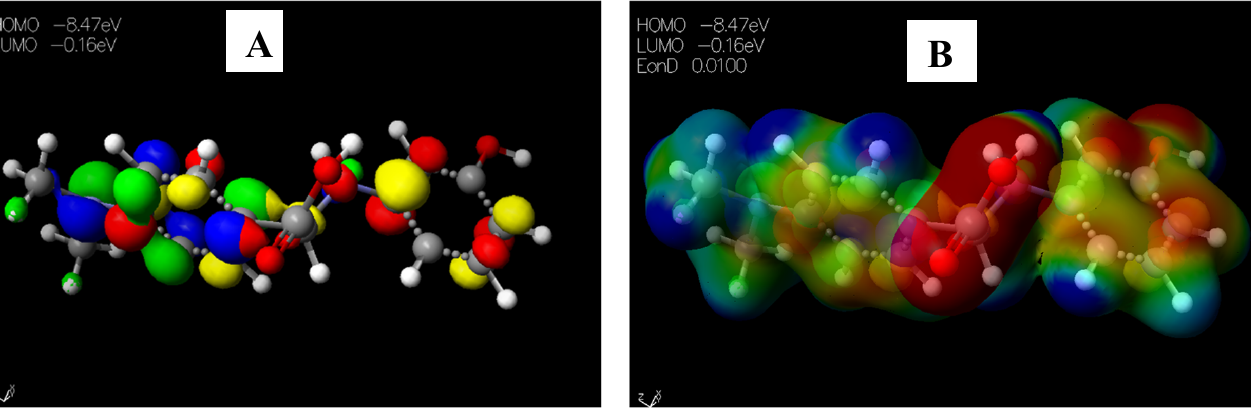
Figure 11. Images showing the ( A ) Highest occupied molecular orbital (HOMO) and Lowest unoccupied molecular orbital (LUMO) and ( B ) Molecular electrostatic potential (MESP) plots of 7.